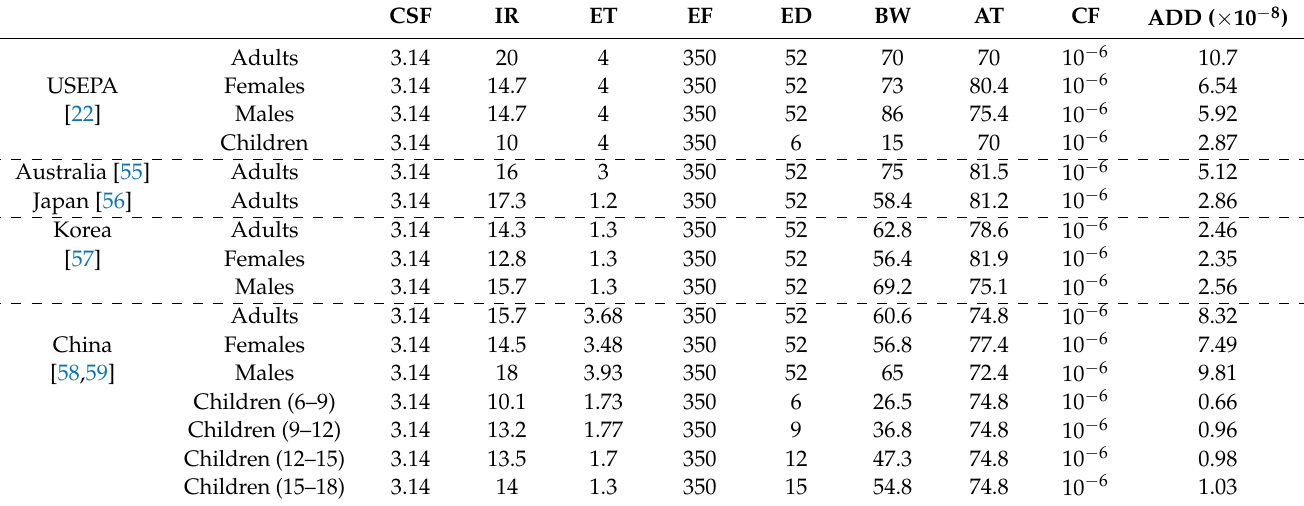
Table 4. Exposure parameters and their values for carcinogenic risk assessment in Model